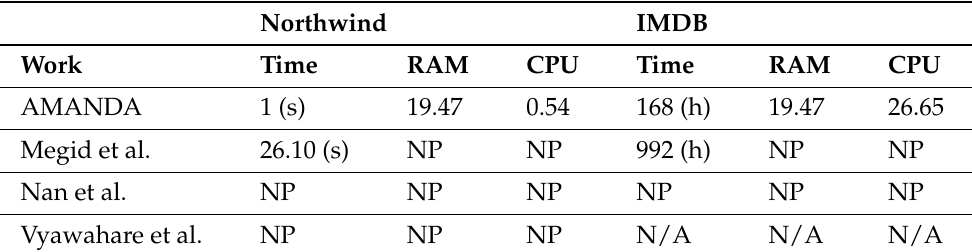
Table 6. Comparison of the migration performance. NP: not provided. Vyawahare did not use IMDB; therefore,